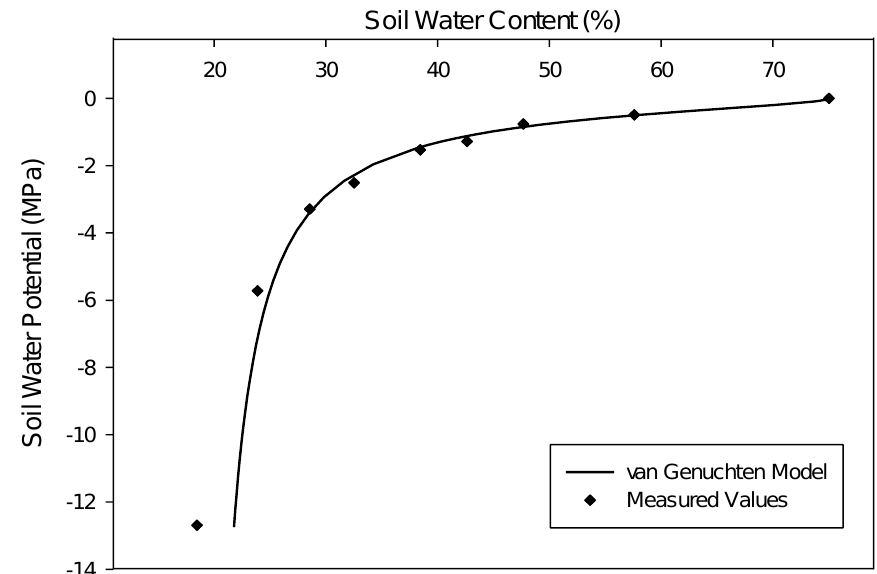
Figure A3. Soil moisture retention curve for the growing medium. Measured values were obtained using a WP4C dewpoint potentiometer, and the van Genuchten model was used for curve fitting. This allowed for the estimation of the required soil water content required to achieve the drought- like conditions.